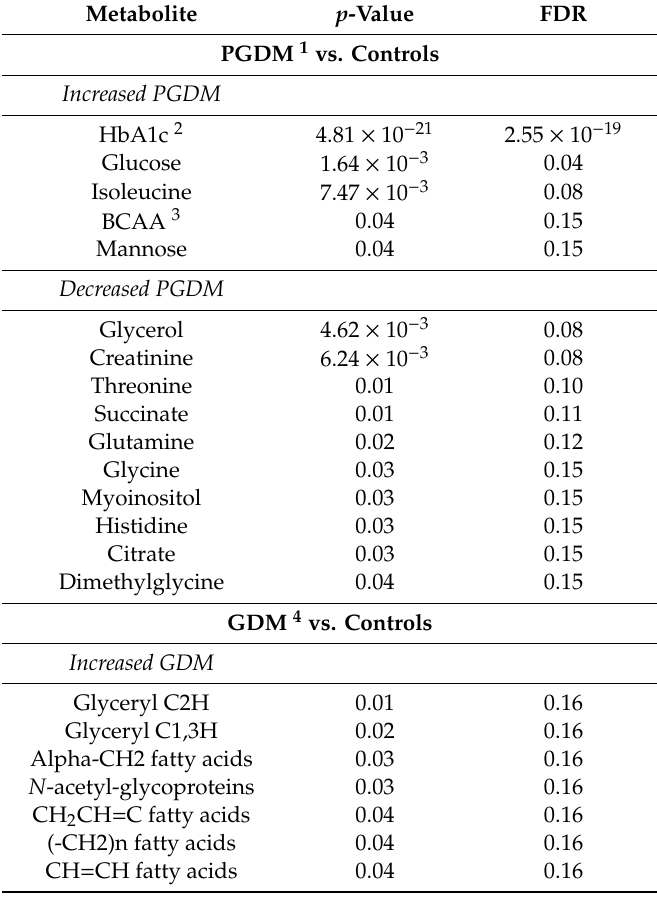
Table 2. Metabolites Significantly Altered in Maternal Serum in PGDM or GDM during